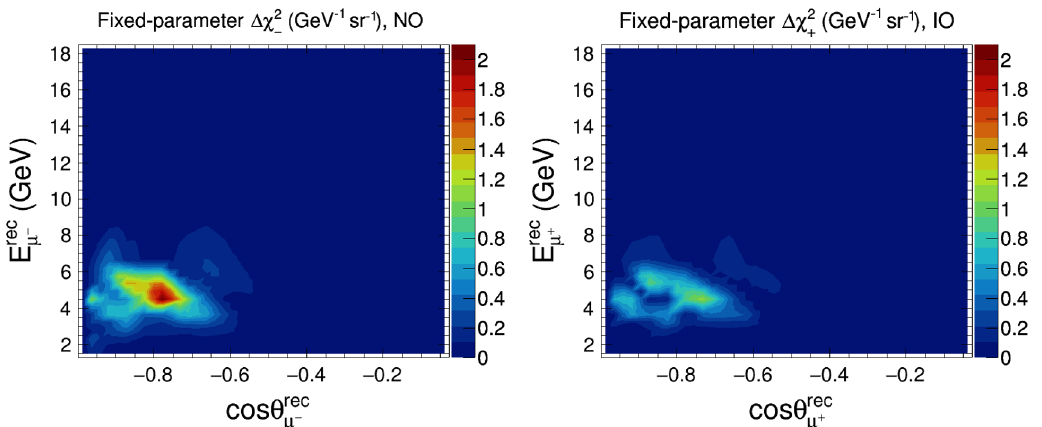
( ∆ χ 2 ) with NO (IO) without pull penalty − + and ∆ χ 2 is plotted in the − + ( ∆ χ 2 ) for IO (NO) is − +